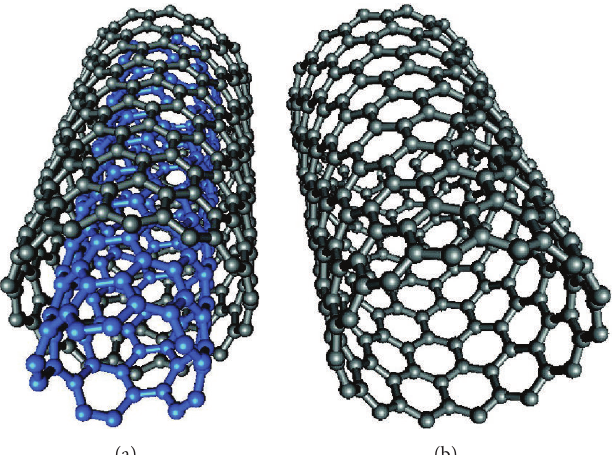
Figure 3: (Super)structure representations of (a) MWCNTs and (b) SWCNTs. Reprinted from [108] with permission. Copyright © 2009, American Chemical